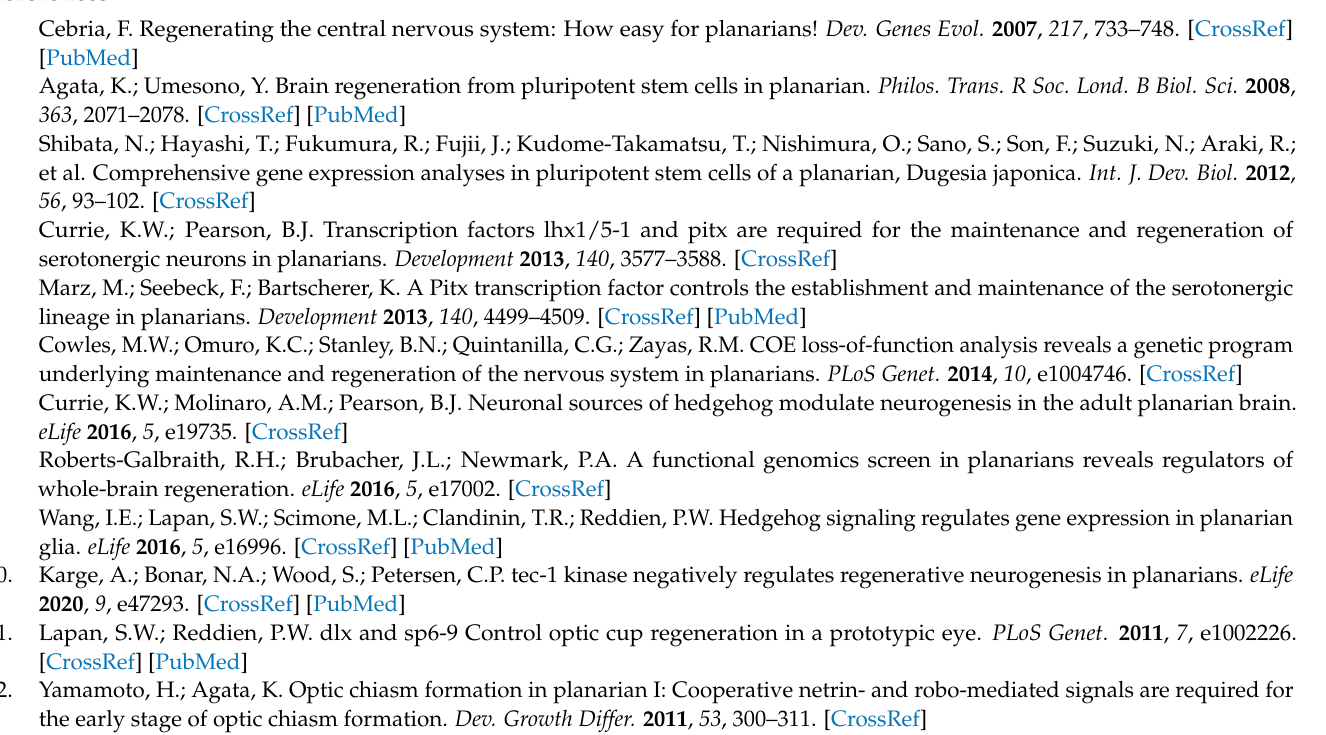
RT-qPCR. Table S2: Oligonucleotides used for the synthesis of the riboprobes. Table S3: List of samples used for RNA-seq. Table S4: Top Blastx hits of the shortlisted candidates. Table S5: GO analysis of the shortlisted, putative